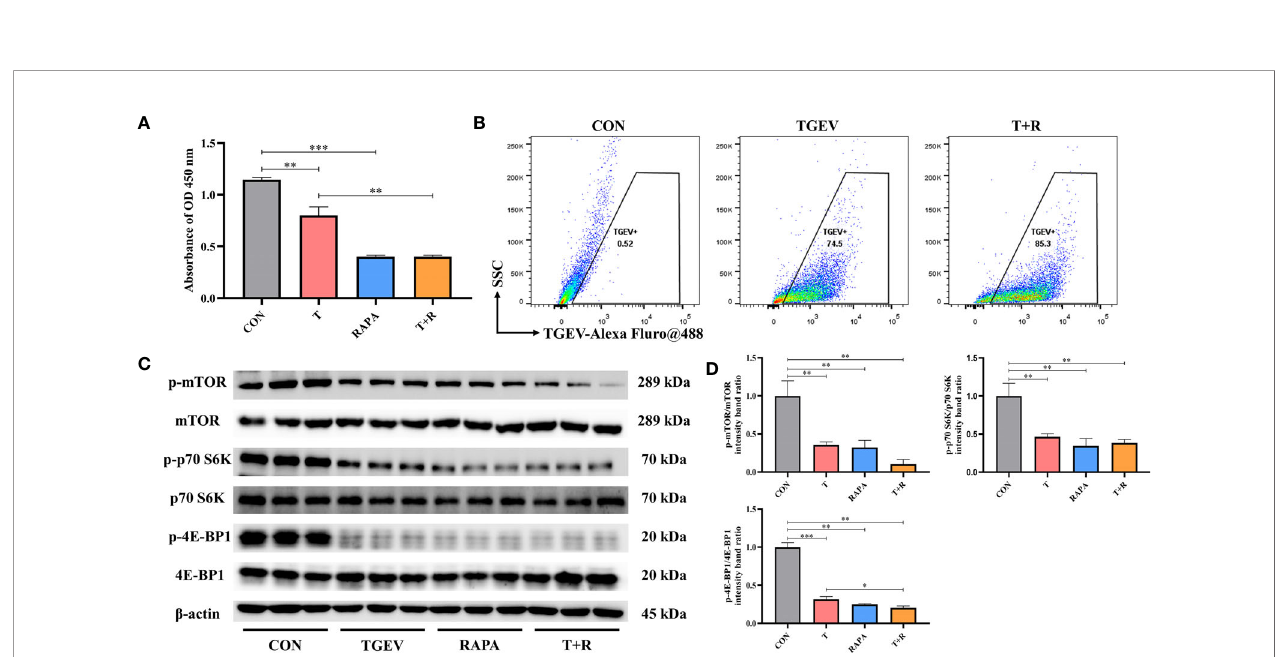
FIGURE 4 | RAPA promoted the TGEV replication by inhibiting mTOR signaling. (A) CCK-8 assay was used to detect the proliferation of IPEC-J2 cells pretreated with 10 nM RAPA, followed by TGEV infection. Data express the mean ± SEM (n = 3). (B) The contents of TGEV were analyzed via fl ow cytometry in the IPEC-J2 cells pretreated with 10 nM RAPA, followed by TGEV infection. (C) The protein levels of p-mTOR, mTOR, p-p70 S6K, p70 S6K, p-4E-BP1 and 4E-BP-1 were detected by western blot. (D) Quantitation of bands to demonstrate the protein level of p-mTOR/mTOR, p-p70 S6K/p70 S6K and p-4E-BP1. Data express the means ± SEMs (n = 3). The symbol * indicates statistically signi fi cant differences ( P < 0.05), ** P < 0.01 and *** P <